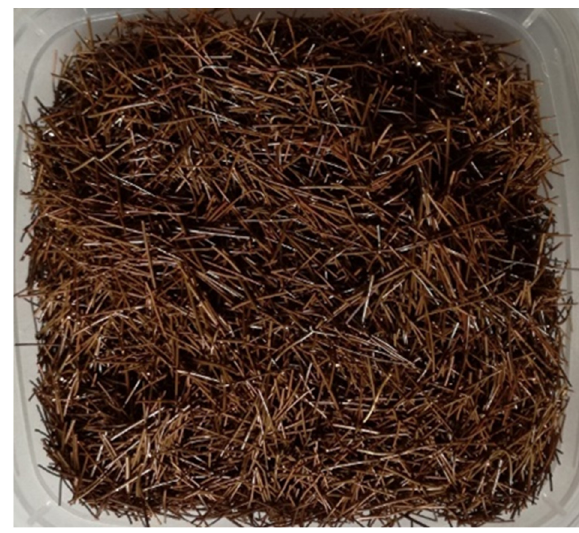
Figure 2. Waste galvanized copper wire fibers. Table 3. Physical properties of waste galvanized copper wire fibers.